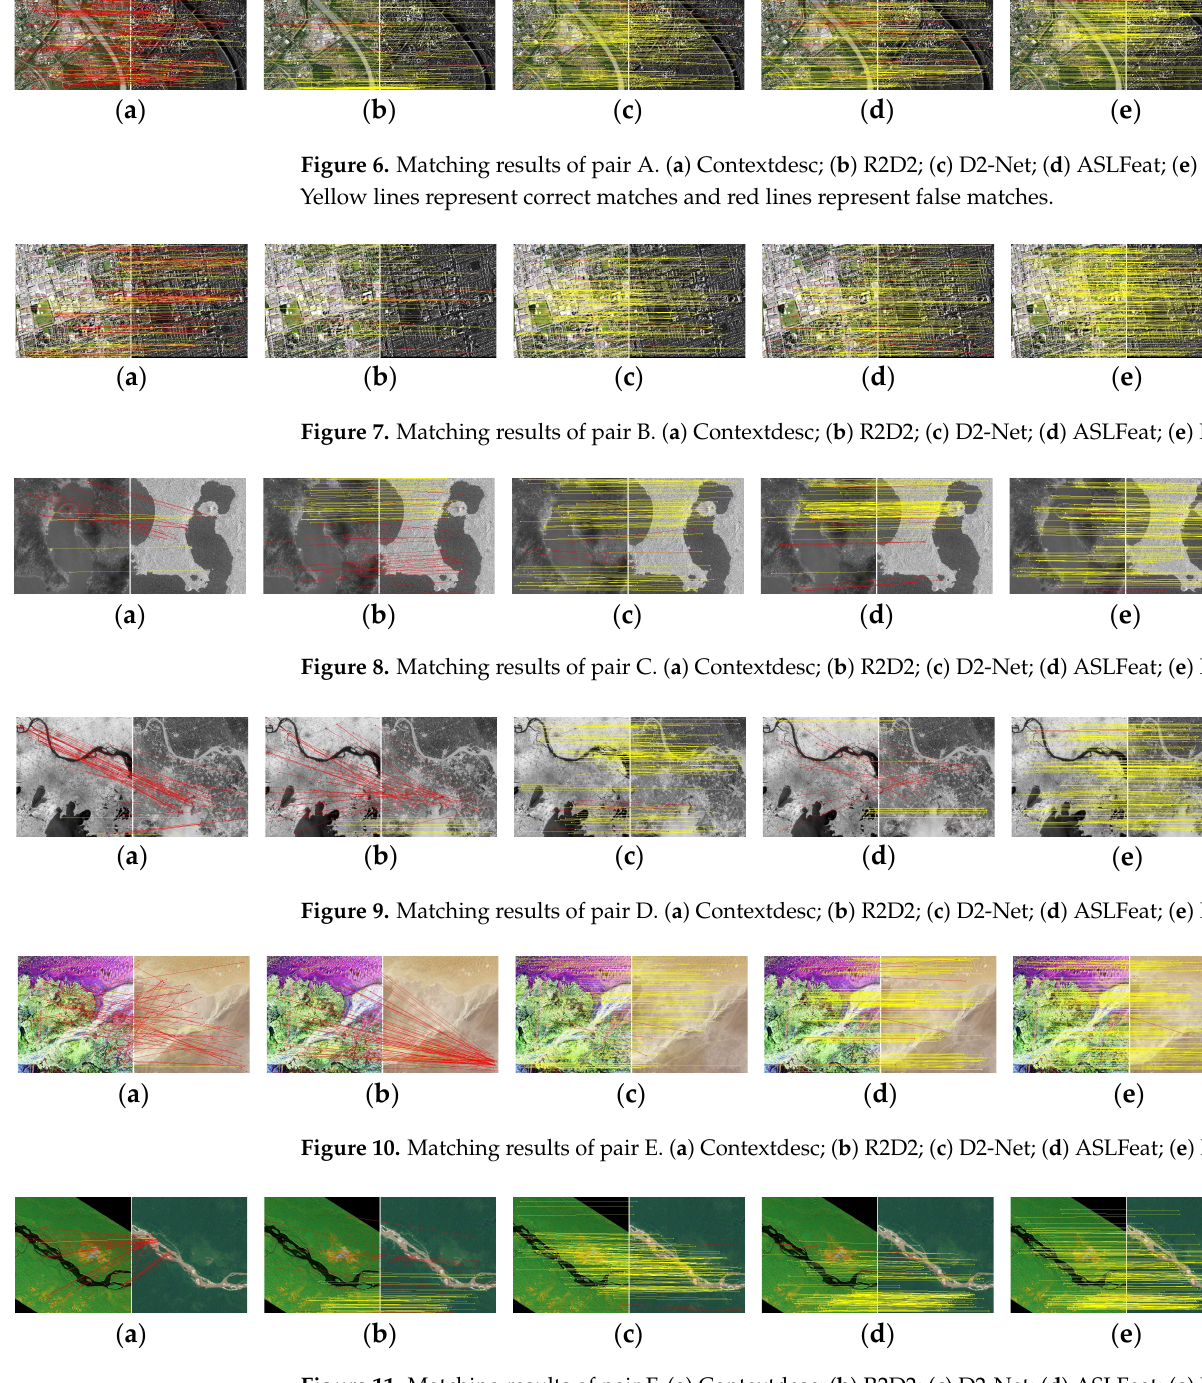
( e ) ( e ) Figure 11. Matching results of pair F. ( a ) Contextdesc; ( b ) R2D2; ( c ) D2-Net; ( d ) ASLFeat; ( e ) PM- Net.